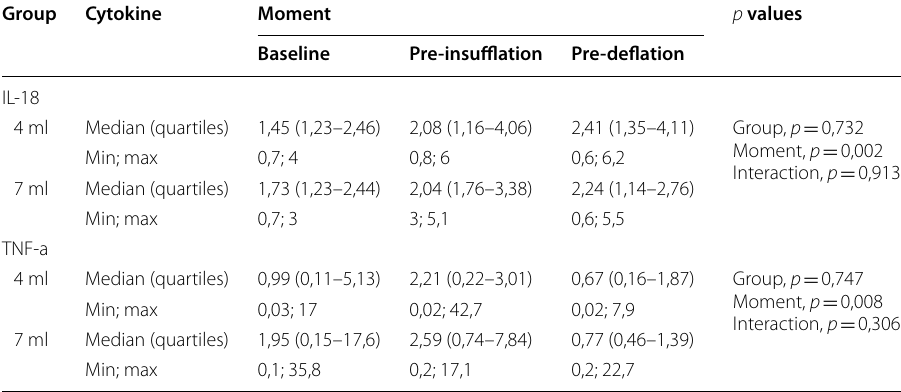
Table 2 Generalized estimating equations results for the cytokines response to ICP elevation Cytokine